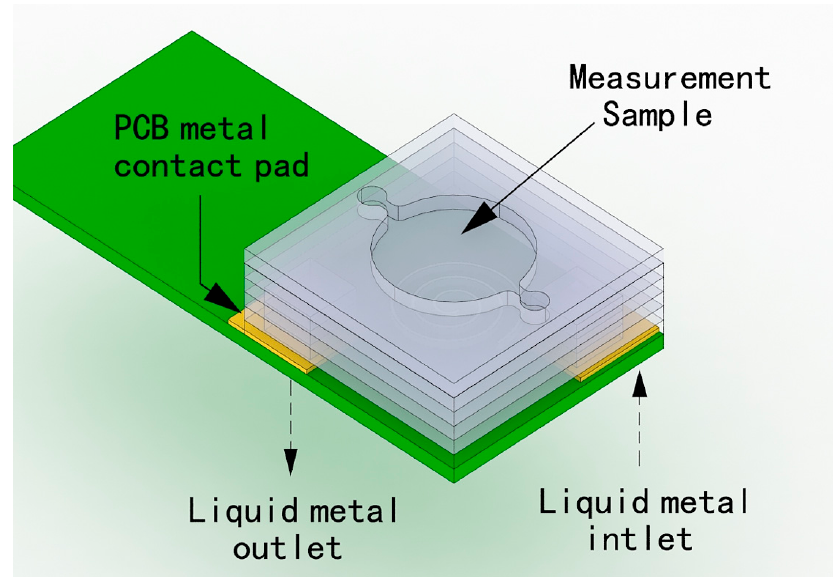
Figure 14. Liquid metal preparation of miniature coils.